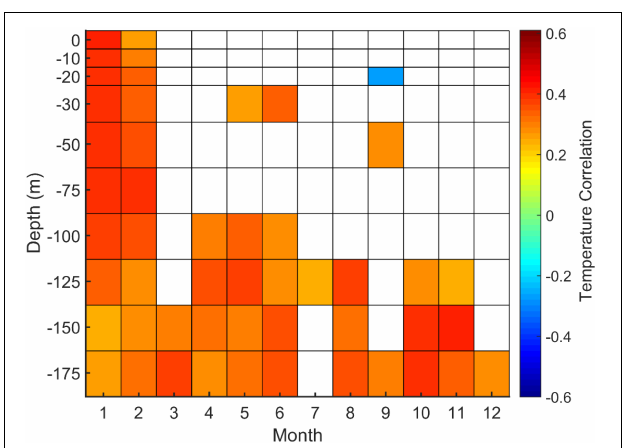
FIGURE 4 | Correlations between A. islandica SGI and Station 27 temperature time series at each depth level (in meter) for each month ( p > 0.05 are not